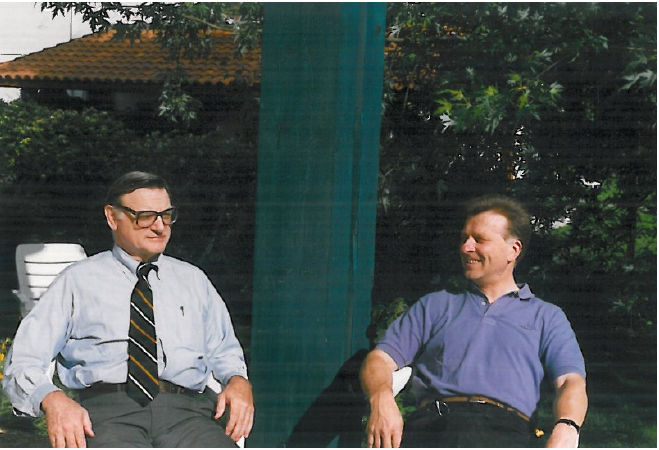
Figure 1. John Goodenough and Jean Etourneau at Jean’s in the summer of 1998.